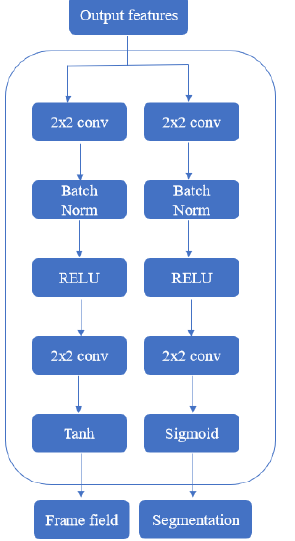
Figure 2. The two branches to produce segmentation and frame